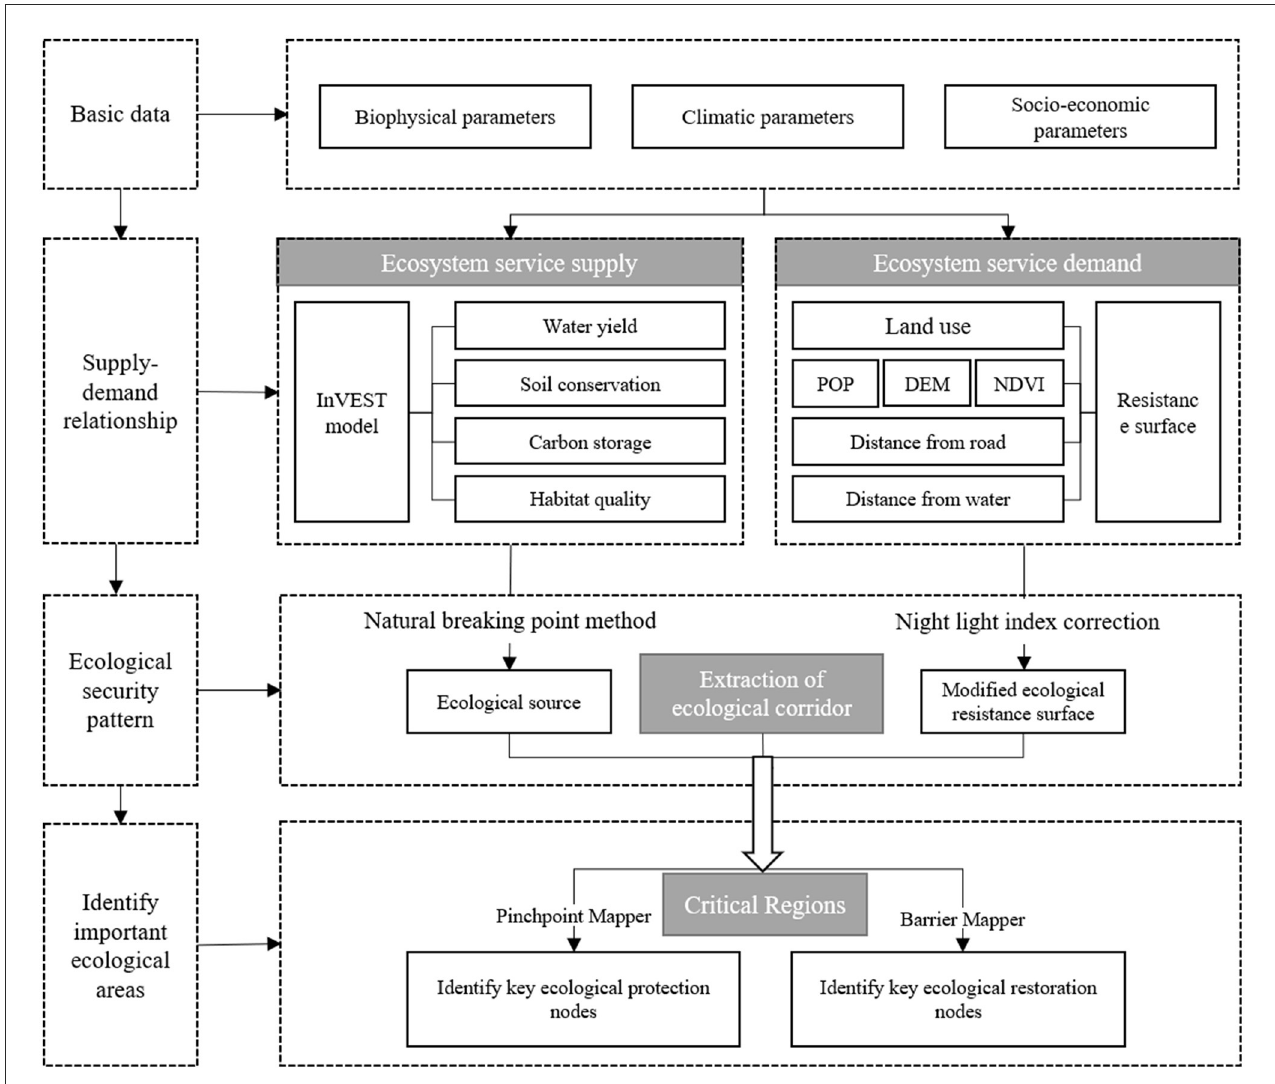
FIGURE2 Research